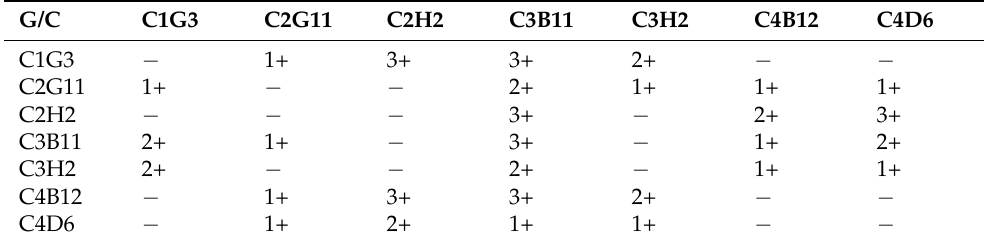
Table 4. Results of the half-pair